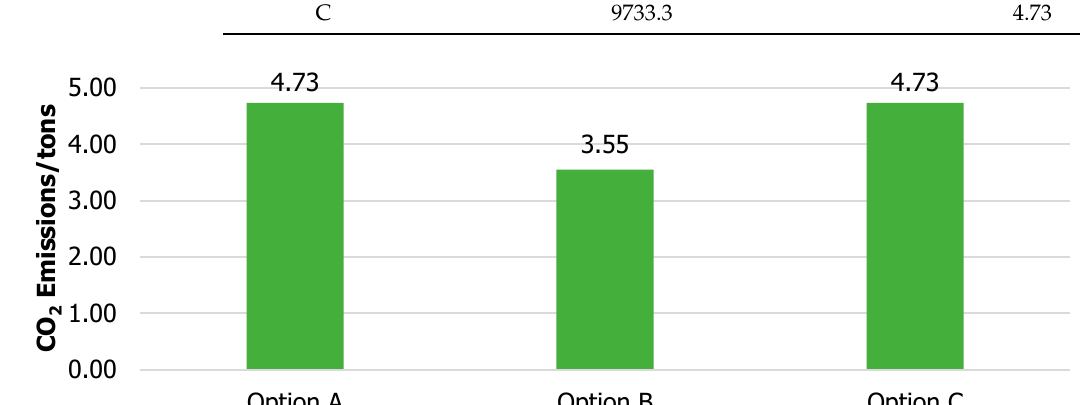
Figure 33. Comparison of CO 2 emissions.